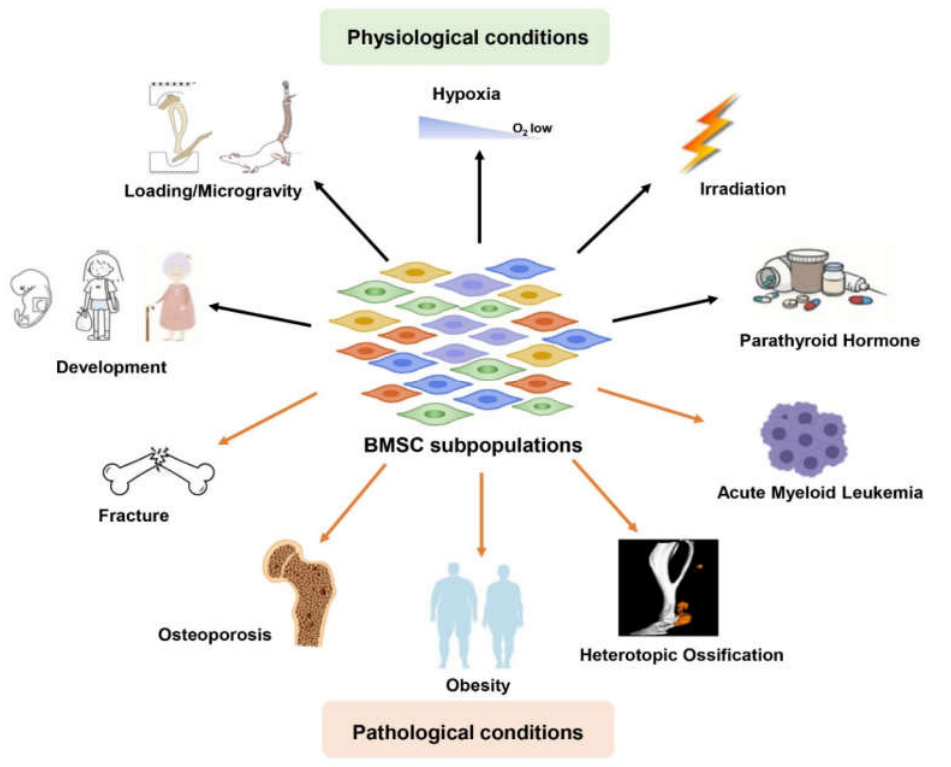
Figure 1. Functional heterogeneity of BMSC subpopulations in physiology and pathology. Physiological conditions include development (embryonic development, adulthood, and aging) and various environmental stresses like loading, microgravity, hypoxia, irradiation, and parathyroid hormone (PTH). Pathological conditions include fracture, osteoporosis, obesity, heterotopic ossification, and acute myeloid leukemia (AML).